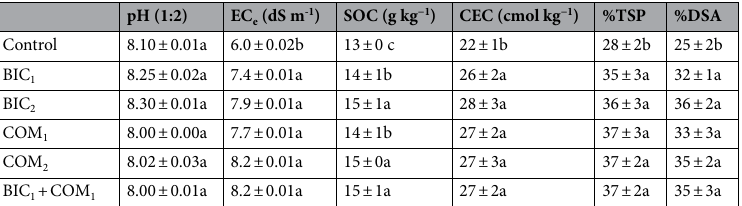
Table 2. Effect of compost and biochar on soil physiochemical properties. Means (± SD, n = 5) denoted by the same letter indicate no significant difference according to Tukey’s multiple range tests at p < 0.05. DSA degree of soil aggregation (%), TSP total soil porosity